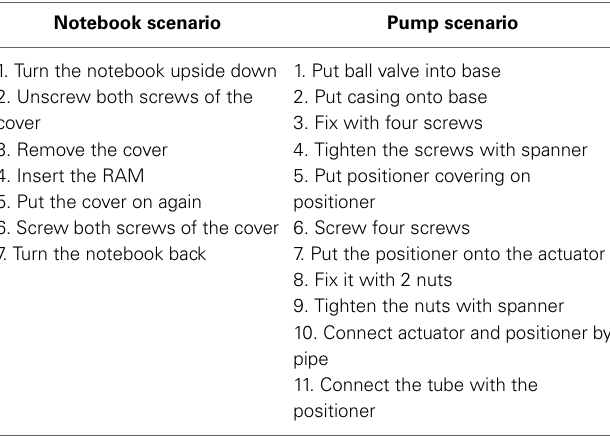
Table 1 | Number of steps during the “instruction creation task” and number of events in the coarse and fine condition during the “event segmentation task.”